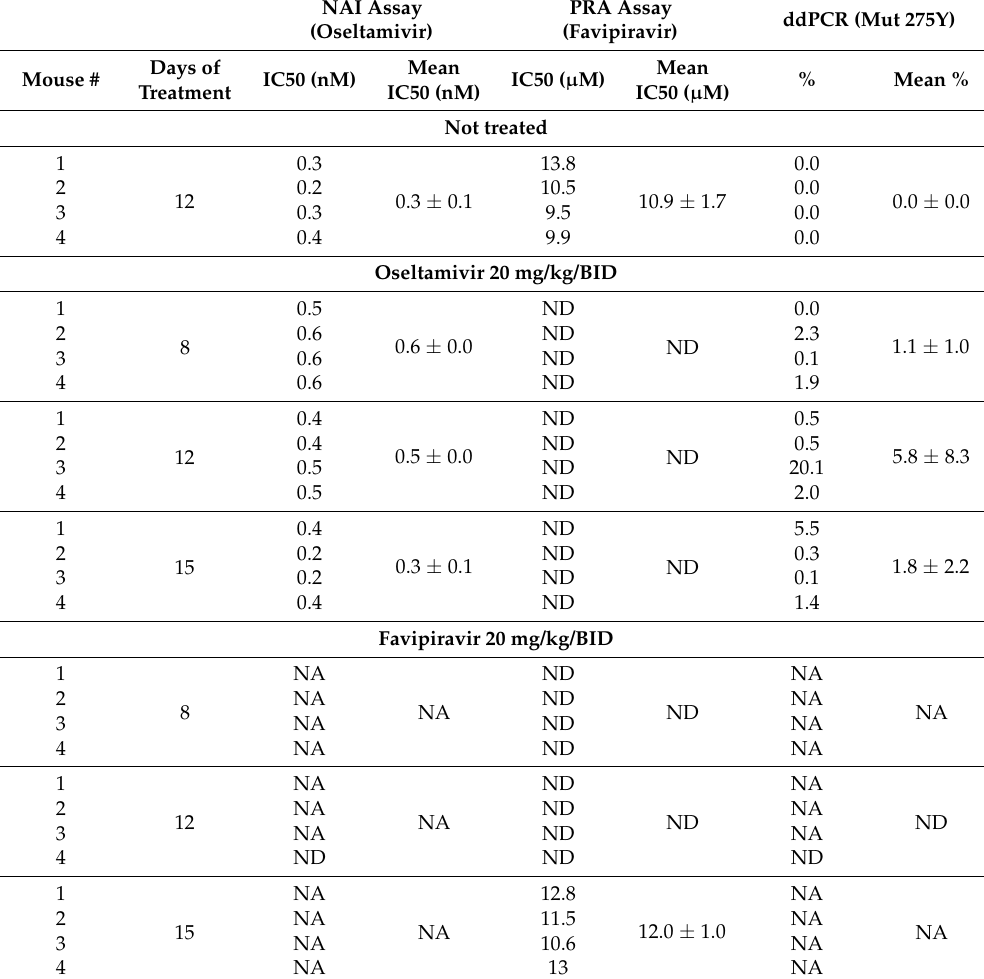
Table 1. Oseltamivir and favipiravir susceptibilities of viruses recovered from individual lungs of IS mice infected with the pH1N1 influenza virus and treated with oseltamivir (20 mg/kg). favipiravir (20 mg/kg) or the combination for 10